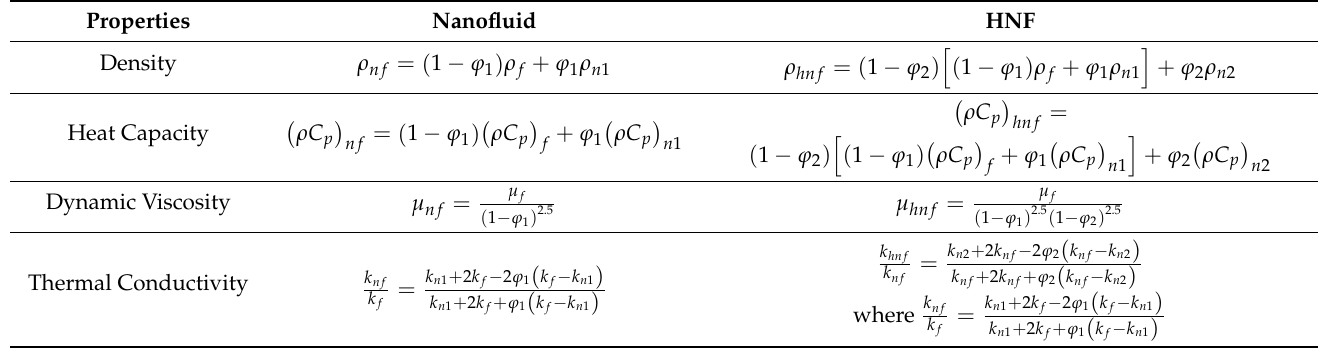
Table 2. Thermophysical attributes of nanofluid and HNF (referring to Waini et al. [8]).